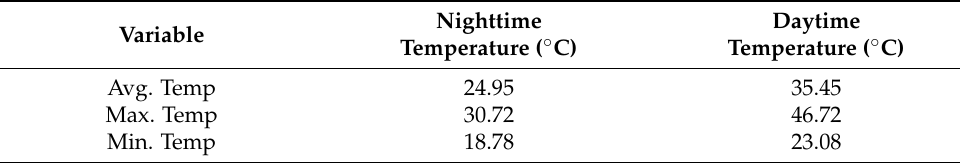
Table 3. Day and night relative humidity conditions at the screen-house. Variable